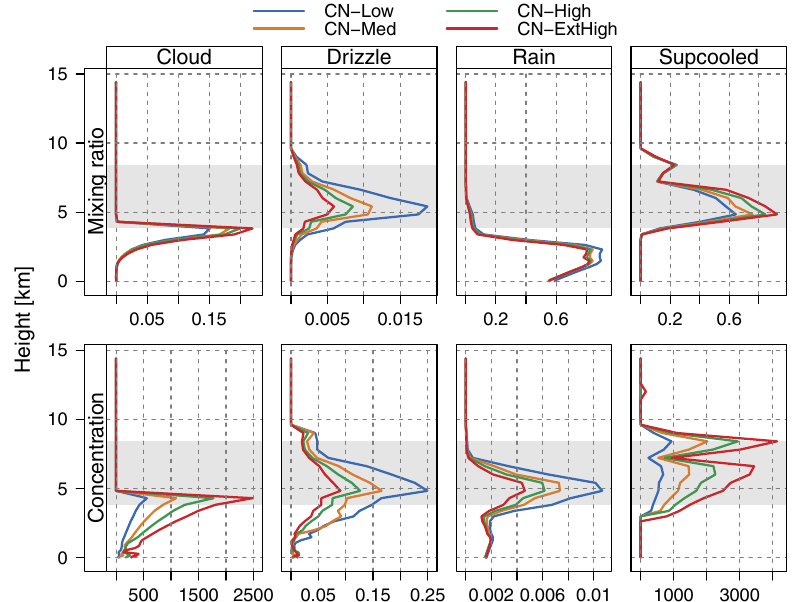
Figure 12. Mean vertical profiles of mixing ratio (gkg − 1 ) and number concentration (1 × 10 6 m − 3 ) for cloud, drizzle, rain and supercooled cloud for the CN-Low (blue), CN-Med (marigold), CN-High (green) and CN-ExtHigh (red) experiments. Only grid columns with updrafts greater than 5ms − 1 are considered in the computation. The shaded area in grey represents the vertical layer between 0 and − 35 ◦ C.